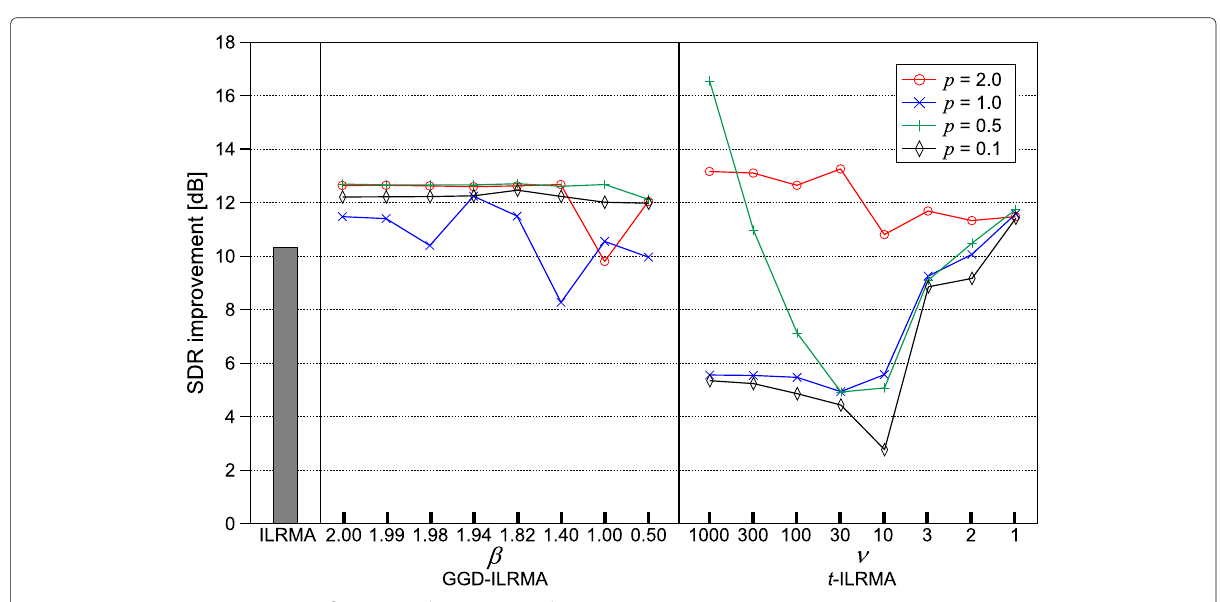
Fig. 17 Average SDR improvements of Music 4 with E2A_1 signal using parameter